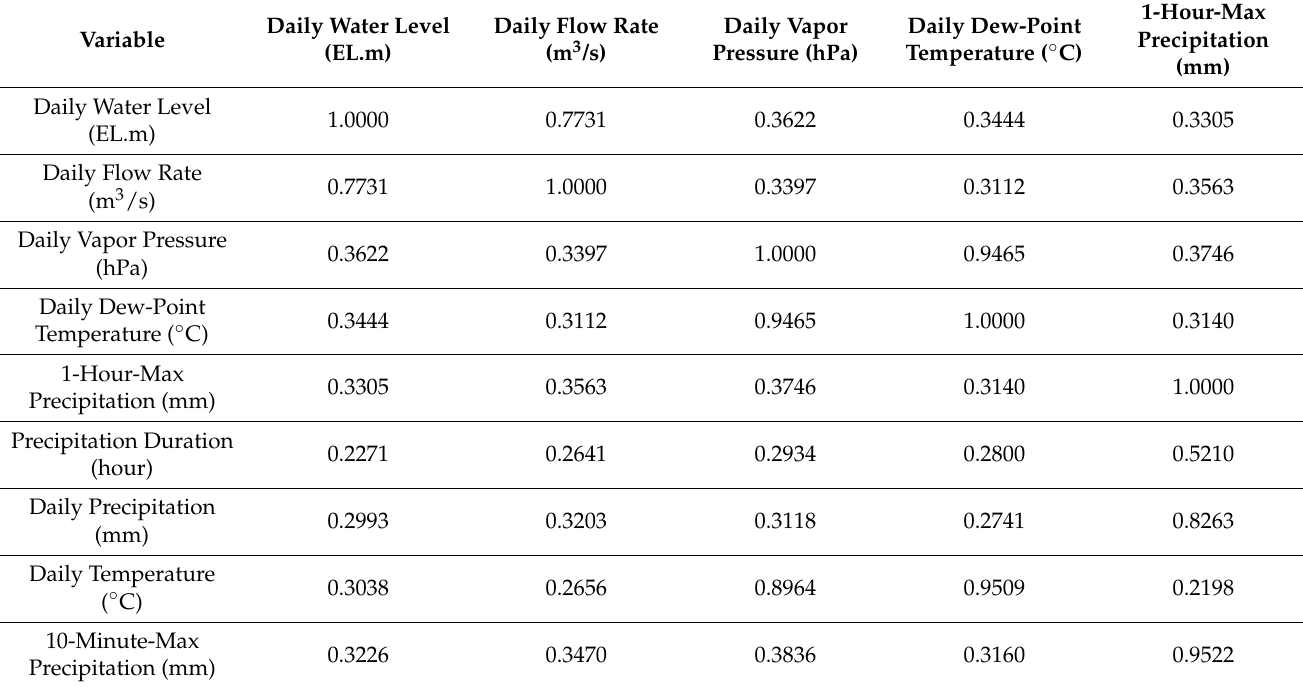
Table 5. Correlation between hydrological and meteorological